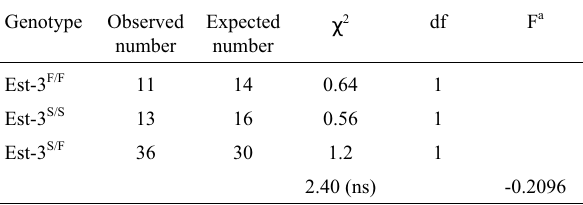
Table III - Comparison of the Genotypic Frequencies of the Est-3 Locus in the Population of Diatraea saccharalis .